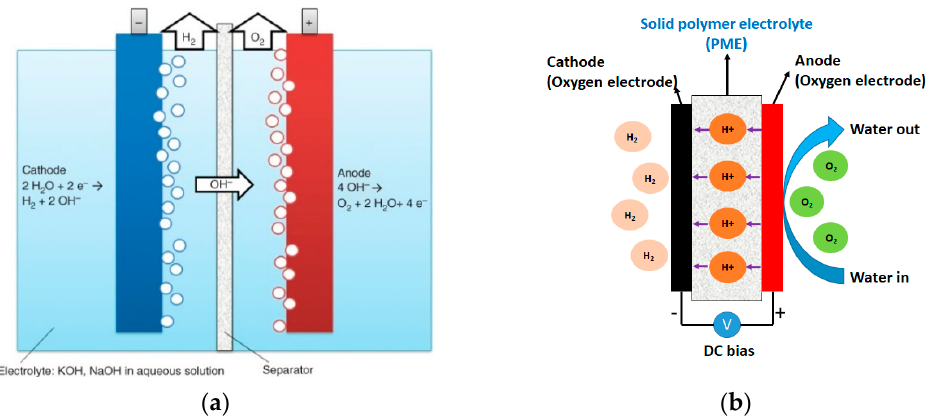
Figure 4. ( a ) H 2 generation from alkaline electrolyzer. Reproduced with permission from [58], John Wiley and Sons, 2022; and ( b ) schematics of PEM water electrolyzer (Solid polymer electrolyte membrane is the same as proton exchange membrane).